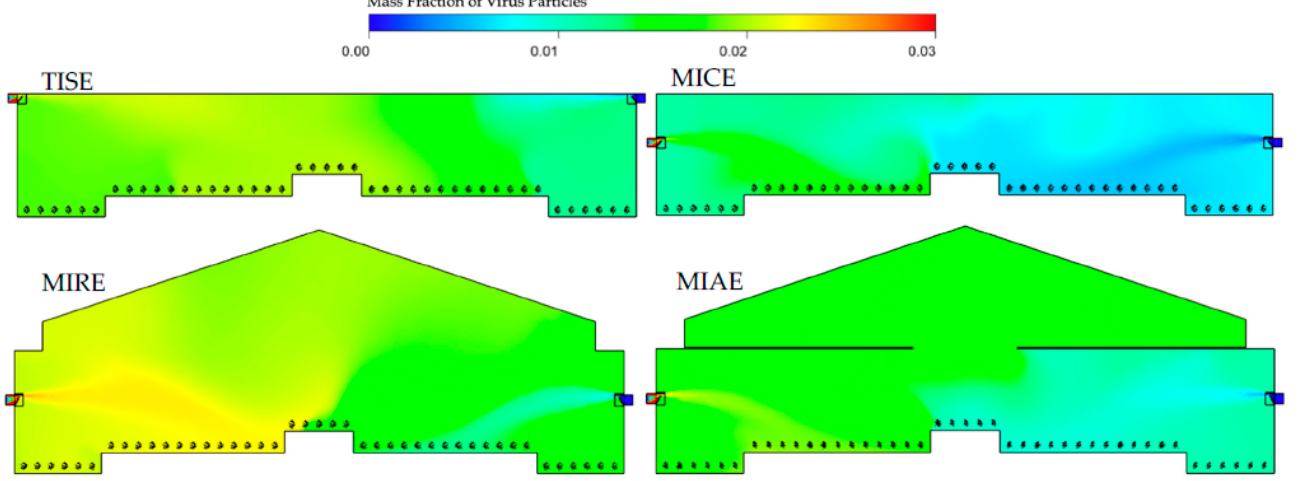
Figure 5. Indoor mass fraction contours of virus particles in the four models (TISE, MICE, MIRE, and MIAE) at the cross-sectional reference plane of CP-I. Individual modeled hens are shown at floor level.